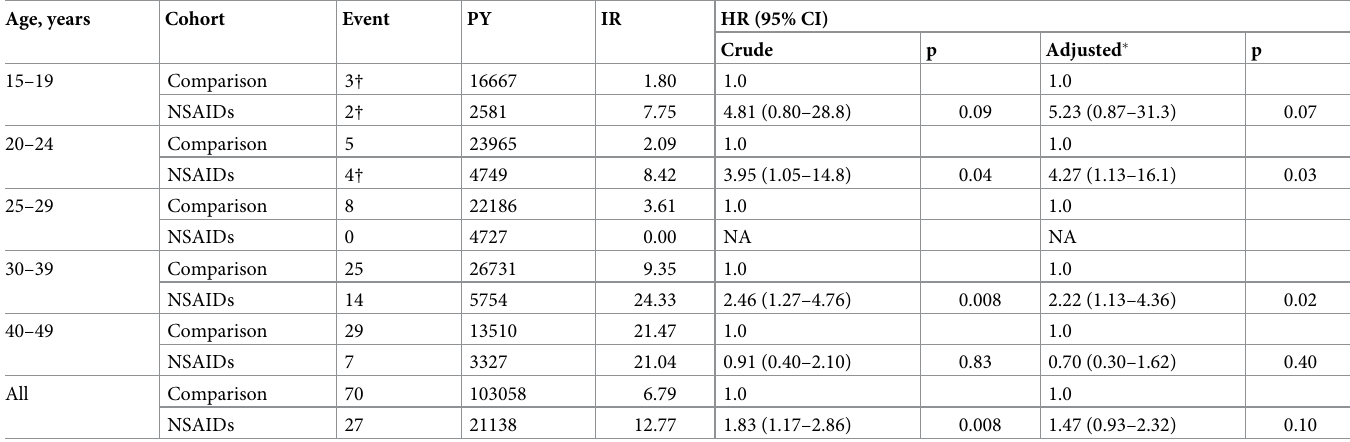
Table 2. Risk of stroke compared between NSAIDs use cohort and comparison cohort among women with dysmenorrhea.